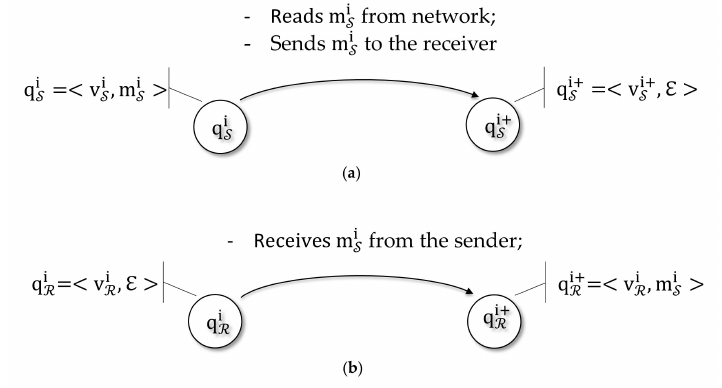
Figure 12. An overview of transition rules on a finite state machine: ( a ) the sender transmits a message to the receiver after reading m i